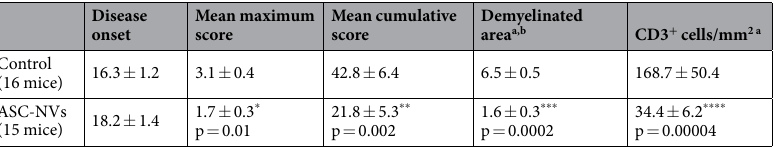
Table 1. Clinical and pathological features of NV-treated EAE mice. The table report the data concerning disease onset, mean maximum/cumulative score, demyelinated area of spinal cord and the quantification of CD3 + cells of NV-treated EAE mice compared to control mice. a Mice sacrificed at disease peak. b % of total SC